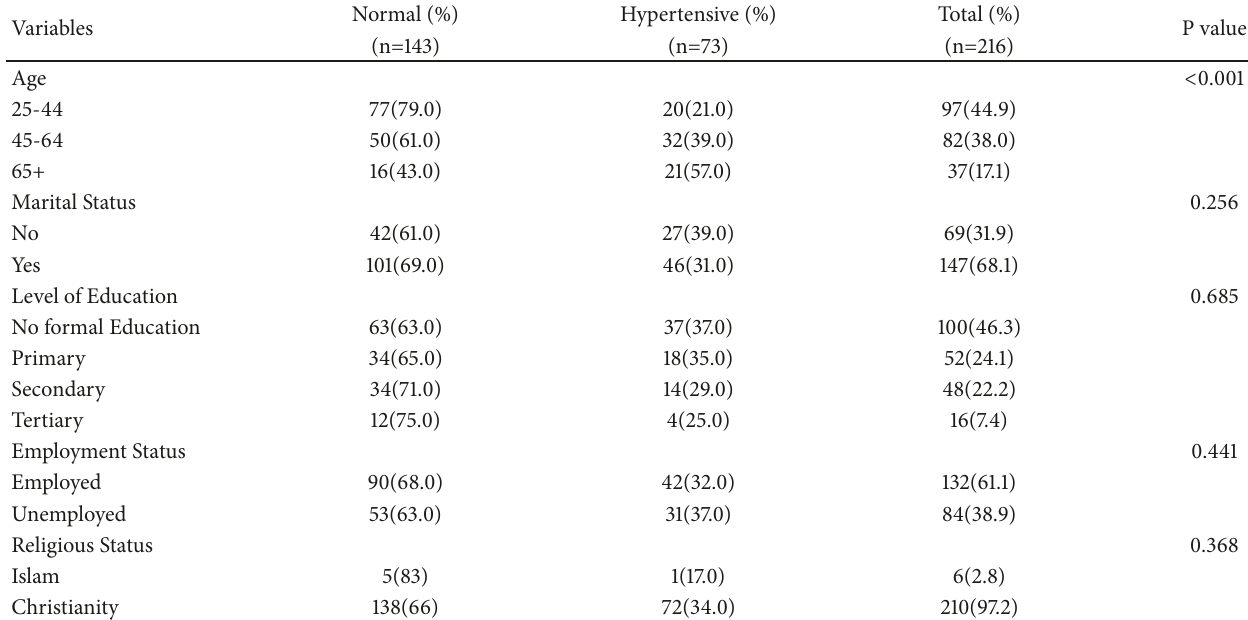
Table 2: Prevalence of hypertension by sociodemographic characteristics.